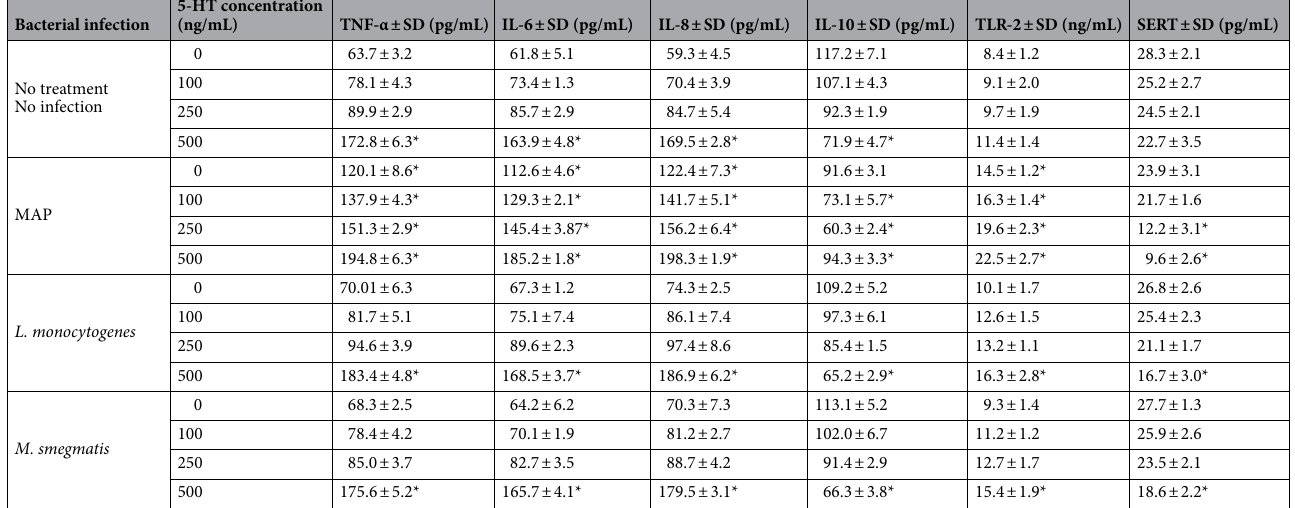
Table 1. Effects of enteropathogenic bacterial infections on protein level of TNF-α, IL-6, IL-10, IL-8, TLR-2 and SERT in Caco-2 monolayers exposed to exogenous 5-HT levels (0, 100, 250 and 500 ng/mL) for 24 h. Values were pre-tested for normal distribution using the Kolmogorov–Smirnov normality test. Significance among experiments was assessed by two-way analysis of variance (ANOVA) followed by Bonferroni correction test. All ELISA experiments were performed in triplicates. * P value <